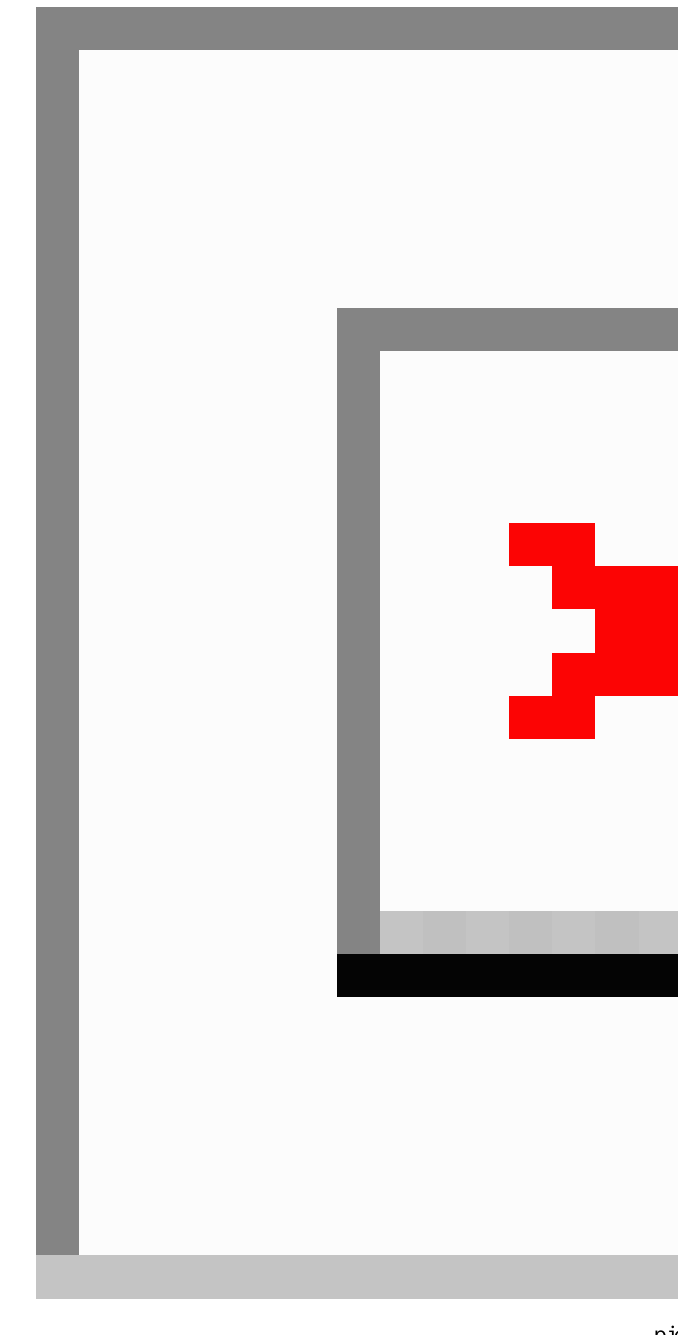
pictogram “take 1 hour before meals”, 7 participants described it as “take with food”, and 4 interpreted as “take 1 hour after food”. Such critical misinterpretations may well explain why Mansoor and Dowse added clocks in their redesign of the pictogram to prevent people from making the time order error